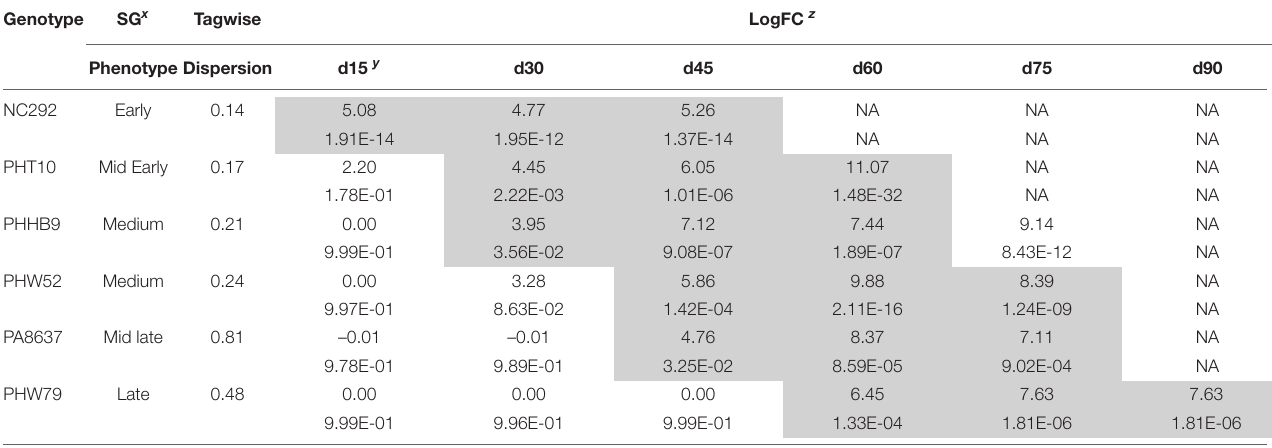
TABLE 5 | Expression profiles fold change and p-value significant differences of six divergent stay-green genotypes studied for the GRMZM2G311347 gene at seven different time points in days (d) after the compared flowering time (d0) as references, d15, d30, d45, d60, d75, and d90 evaluated in Galicia, Spain. Genotype SG x Tagwise LogFC